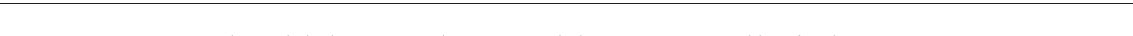
Fig. 1 C9ORF72 associates with ALS-linked stress granule proteins including p62. a Western blot of endogenous C9ORF72 immunoprecipitates compared to immunoprecipitation with non-speci fi c IgG from cell lysates (input) transfected with control or C9ORF72 siRNA. Secondary antibody speci fi c for IgG light chain was used. b Western blot of endogenous C9ORF72 immunoprecipitates with and without arsenite treatment. c Left, Venn-diagram depicting the number of proteins in the putative C9ORF72 interactome that localize to stress granules (SGs, blue) or contain mutations linked to ALS (olive); Right, western blot of immunoprecipitation of C9ORF72-myc for p62 and SG proteins (FUS, SMN). d Immuno fl uorescence of endogenous C9ORF72 and SGs (FMRP) after 30 min incubation with Sodium Arsenite, (0.5 mM); Right, quanti fi cation of the percentage of SGs (FMRP + ) co-localizing with foci of C9ORF72 (quanti fi ed 3916 C9ORF72 punctae and 3331 SGs). e Western blot of HA-p62 immunoprecipitates with and without arsenite treatment. f PLA co-labeling with species controlled IgG (top, negative control) and known interactors p62 and LC3 (bottom, positive control); p62-LC3 association was tested in cells treated with Ba fi lomycin A1 (Baf A1). g Top, proximity ligation assay (PLA) for C9ORF72 and NBR1 in arsenite-treated cells; Bottom, immuno fl uorescence for NBR1 showing antibody does label cells. h PLA for endogenous p62 and C9ORF72 in cells treated with arsenite and transfected with control (Ctl) or C9ORF72 (C9) siRNA. i Quanti fi cation of PLA signals for C9ORF72 and p62 in the cytoplasm and nucleus in identical conditions to ( h ) ( n = 3, mean ± SD, Student ’ s t -test). j Western blot of recombinant p62 and GST-C9ORF72 from in vitro pulldown assay. k Representative immunoprecipitation of HA-p62 used for identi fi cation of putative p62 interacting proteins using LC-MS/MS. l Venn-diagram depicting number of proteins in predicted p62 interactome that localize to SGs (blue). m Western blot of immunoprecipitates of HA-p62 detecting known interactors (LC3, ubiquitinated proteins), candidate interactors identi fi ed by LC-MS/MS (GFP-DDX3) and control RNA-binding proteins that do not associate with p62 (EWS) in cells treated or not with arsenite. n Western blot of immunoprecipitations of endogenous p62 (top) and HA-p62 (bottom) for other SG proteins (FUS, SMN). HeLa cells were used in all experiments. Scale bar = 10 µ m. Molecular weight markers for blots, where not shown, are included in the uncropped